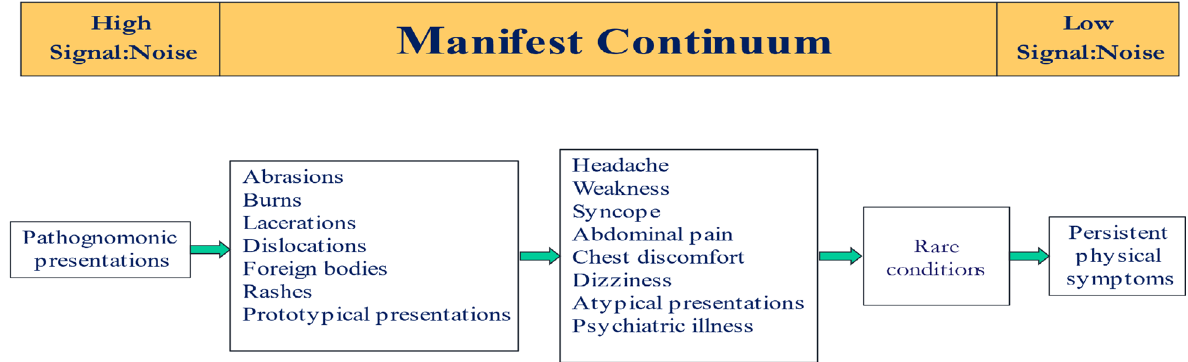
Fig. 4 Manifest continuum of diseases. Adapted from Croskerry (2020) See text for